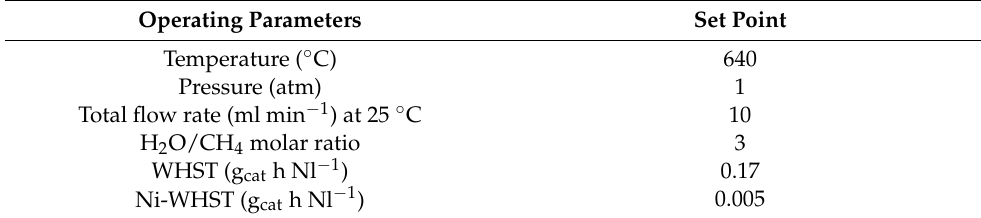
Figure 1. Experimental setup: 1: gas lines; 2: mass flow controllers; 3: water and toluene HPLC pumps; 4: furnace and reactor; 5–6: six-ways valves; 7: thermocouple; 8: chromatographs; 9: computer. Table 1. Operating conditions of steam methane reforming